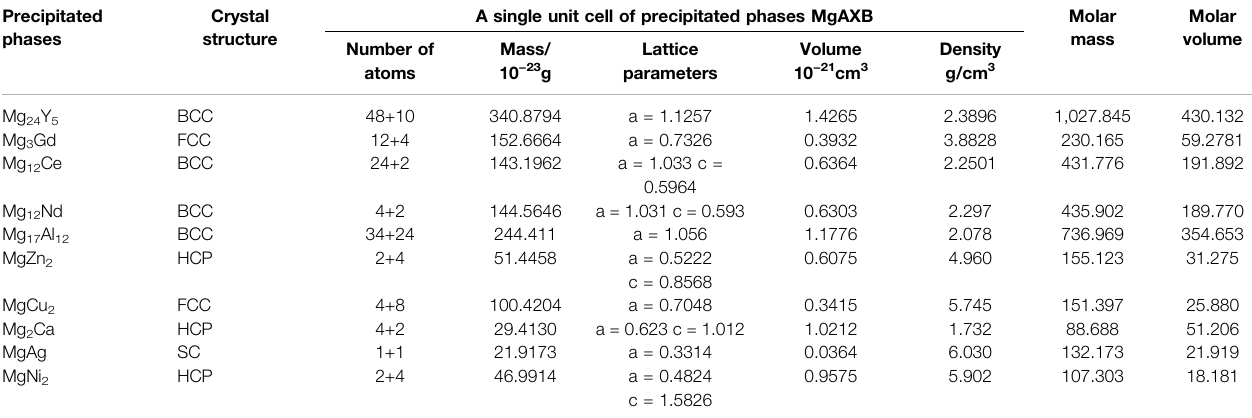
TABLE 2 | Molar volume of precipitated phases Mg A X B in magnesium